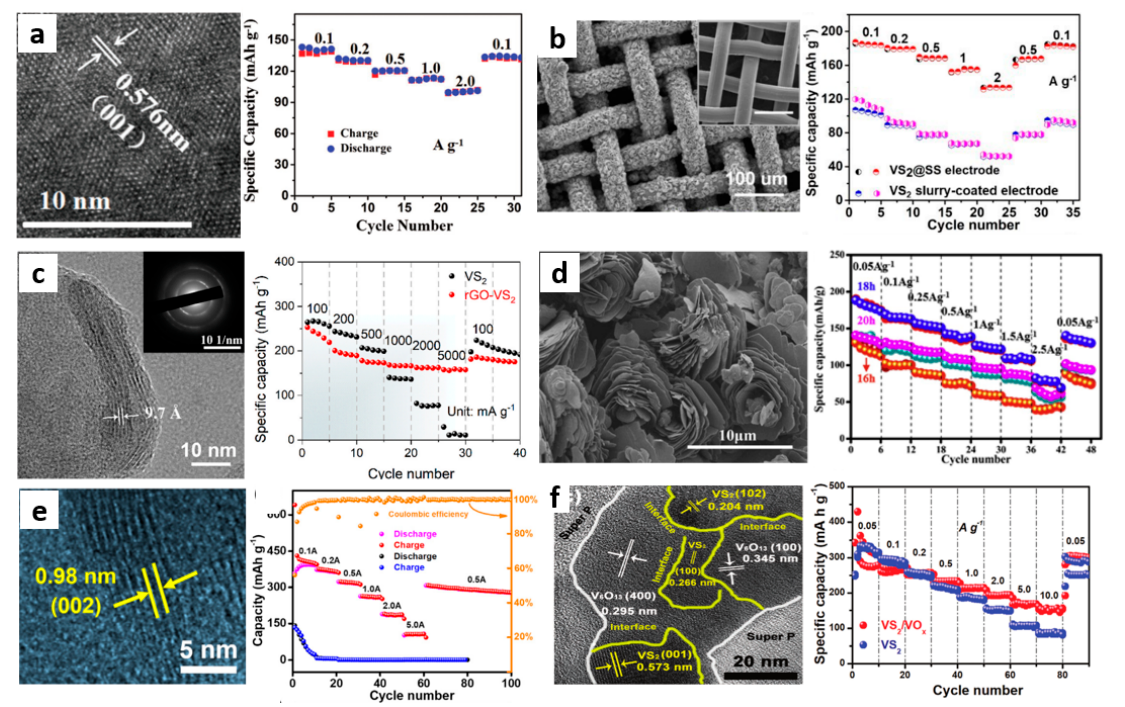
Figure 7. ( a ) HR − TEM image and rate performance of layered VS 2 [45]; ( b ) SEM image of VS 2 grown on SS mesh and rate performance of VS 2 @SS electrode [46]; ( c ) HRTEM image and rate performance of the rGO − VS 2 composites [47]; ( d ) SEM image and rate performance of the VS 2 @VOOH − 18h [48]; ( e ) HRTEM image and rate performance of VS 2 · NH 3 electrode [49]; ( f ) TEM image and rate capability of in − situ electrochemical oxidation formed VS 2 /VO x [50].